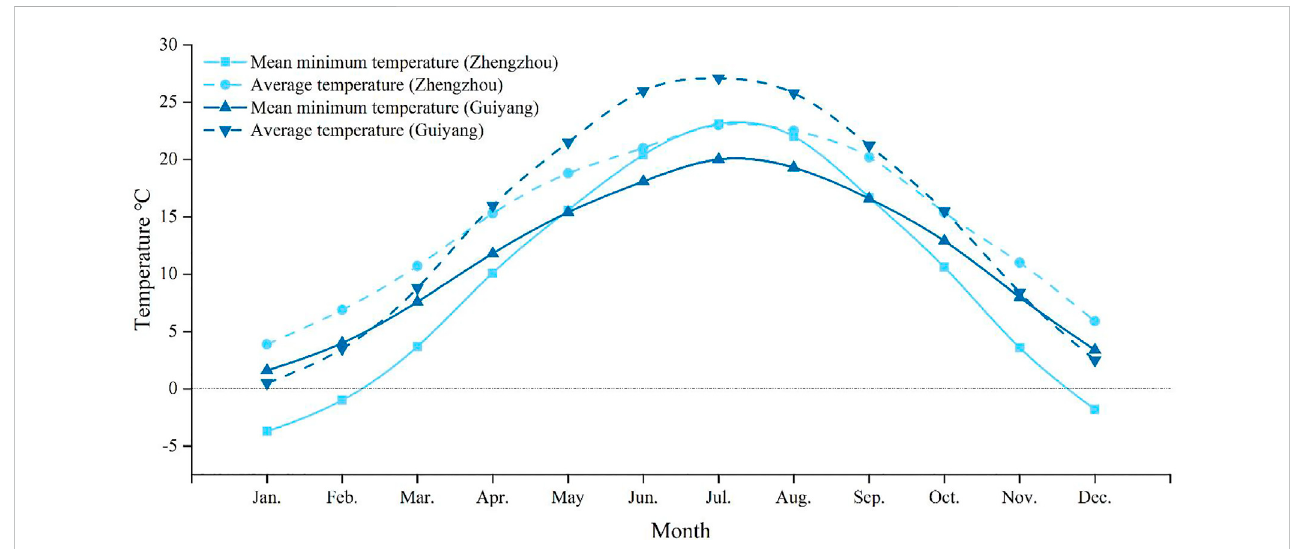
FIGURE 1 The monthly average temperature and monthly mean minimum temperature in Guizhou (Guiyang) and Henan (Zhengzhou) provinces from 1981 to 2010. The data comes from China Meteorological Data Service Centre